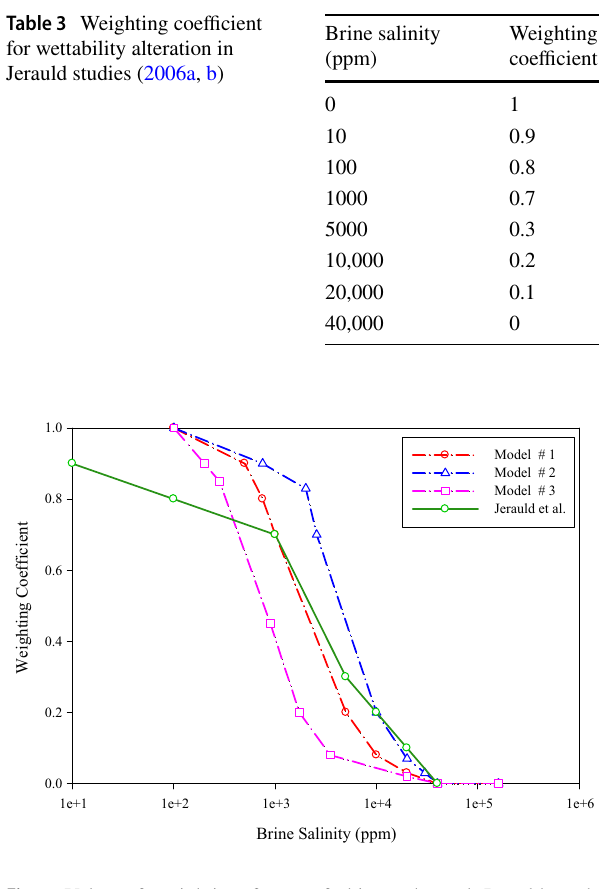
Fig. 6 Value of weighting factor of this study and Jerauld